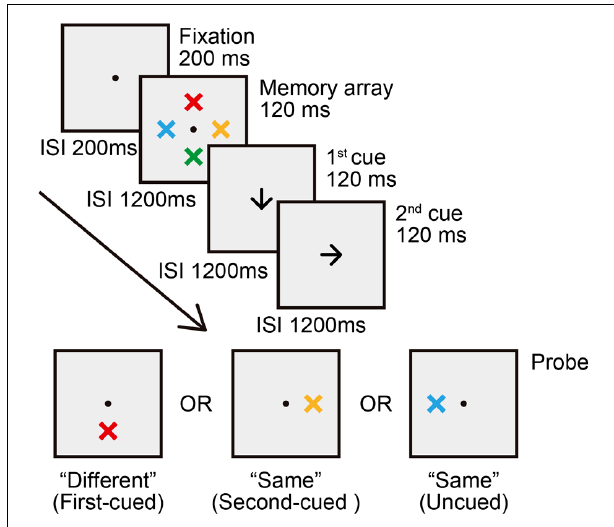
FIGURE 4 |Trial sequence for the “double spatial cue”(DS) condition in Experiment 2 and